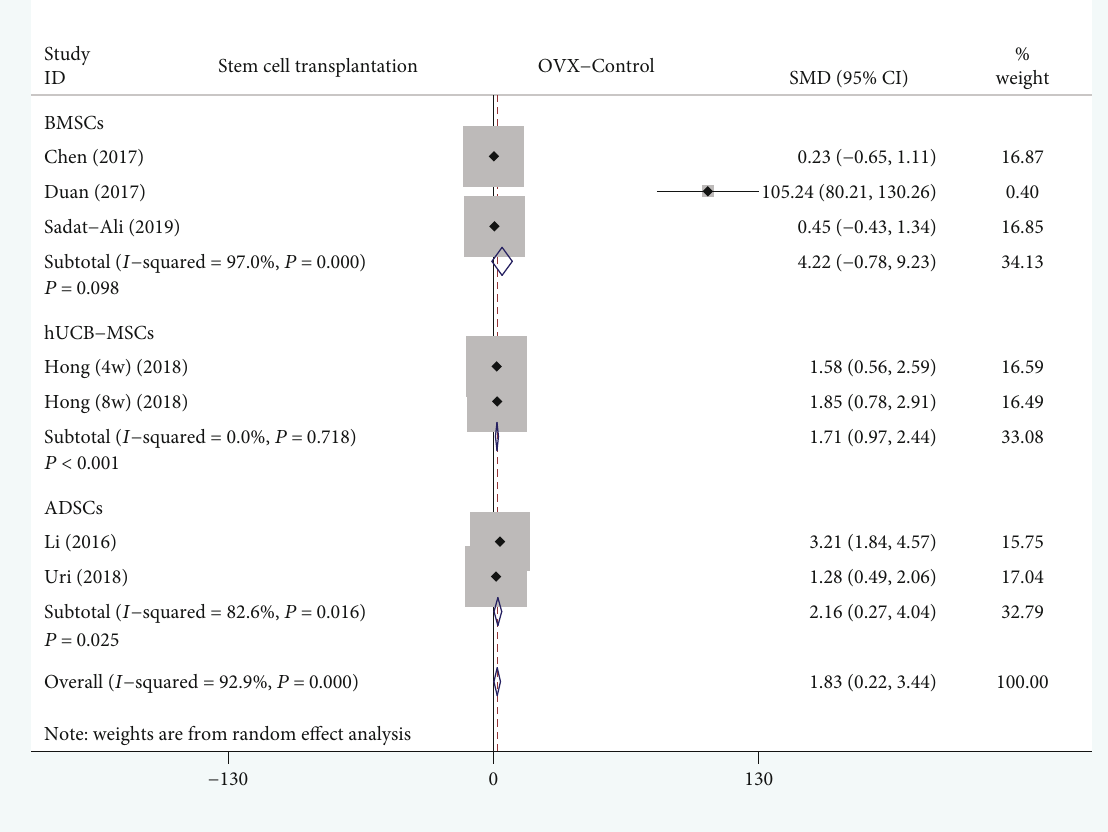
Figure 5: Forest plot showing the e ff ect of stem cell treatment group compared with OVX control group on BV/TV. BV/TV: bone volume/total volume; BMSCs: bone marrow mesenchymal stem cells; hUCB-MSCs: human umbilical cord blood-derived mesenchymal stem cells; ADSCs: adipose-derived stem